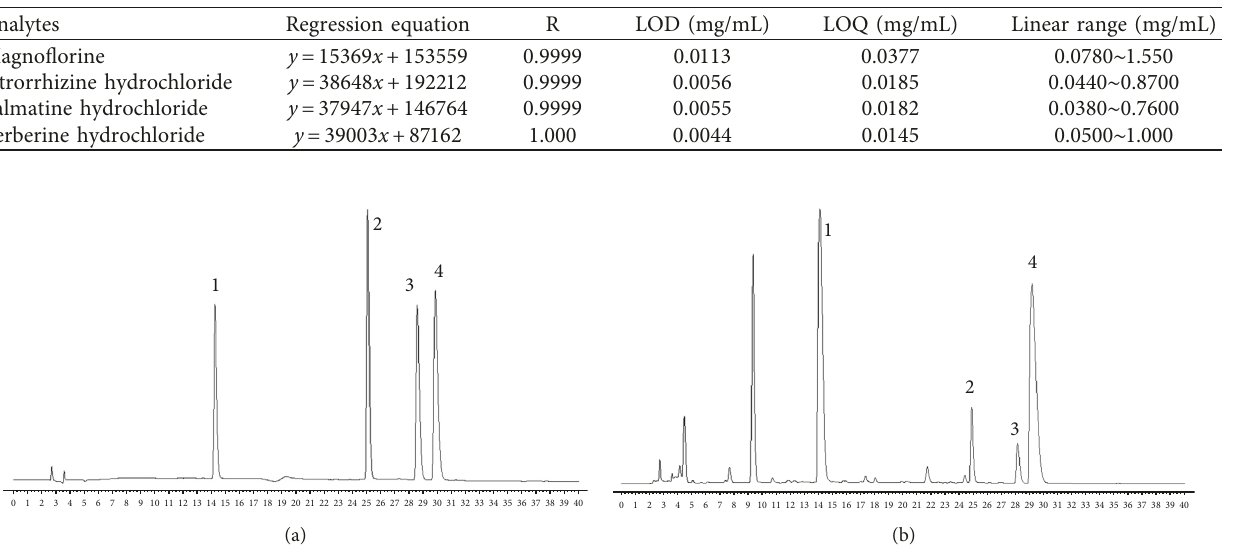
Table 2: Calibration curves of four alkaloids of the reference substance.